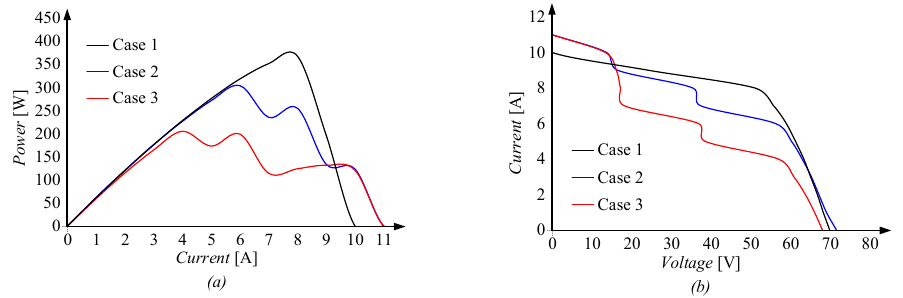
Table 5. Experiment Results of Multiple Series Connections of PVEs for Case 1, 2, and 3.